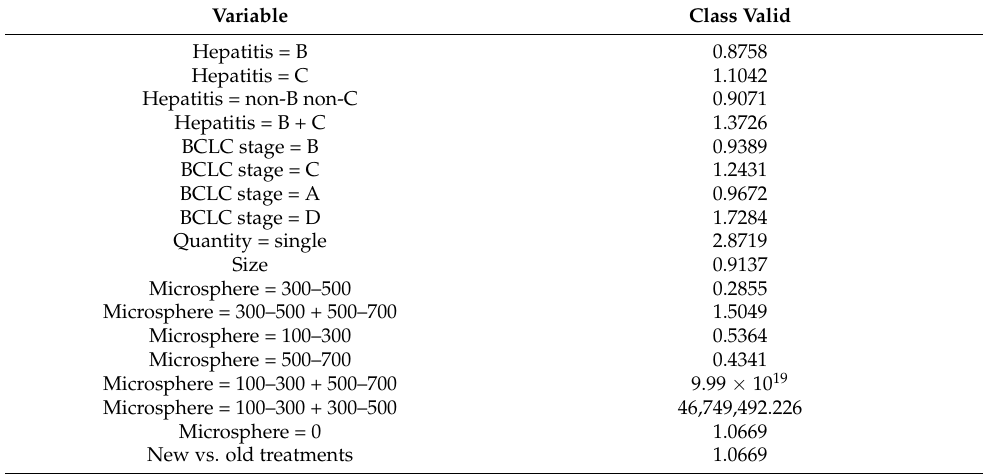
Table 3. Logistic regression output results (odds ratios expressed as regression